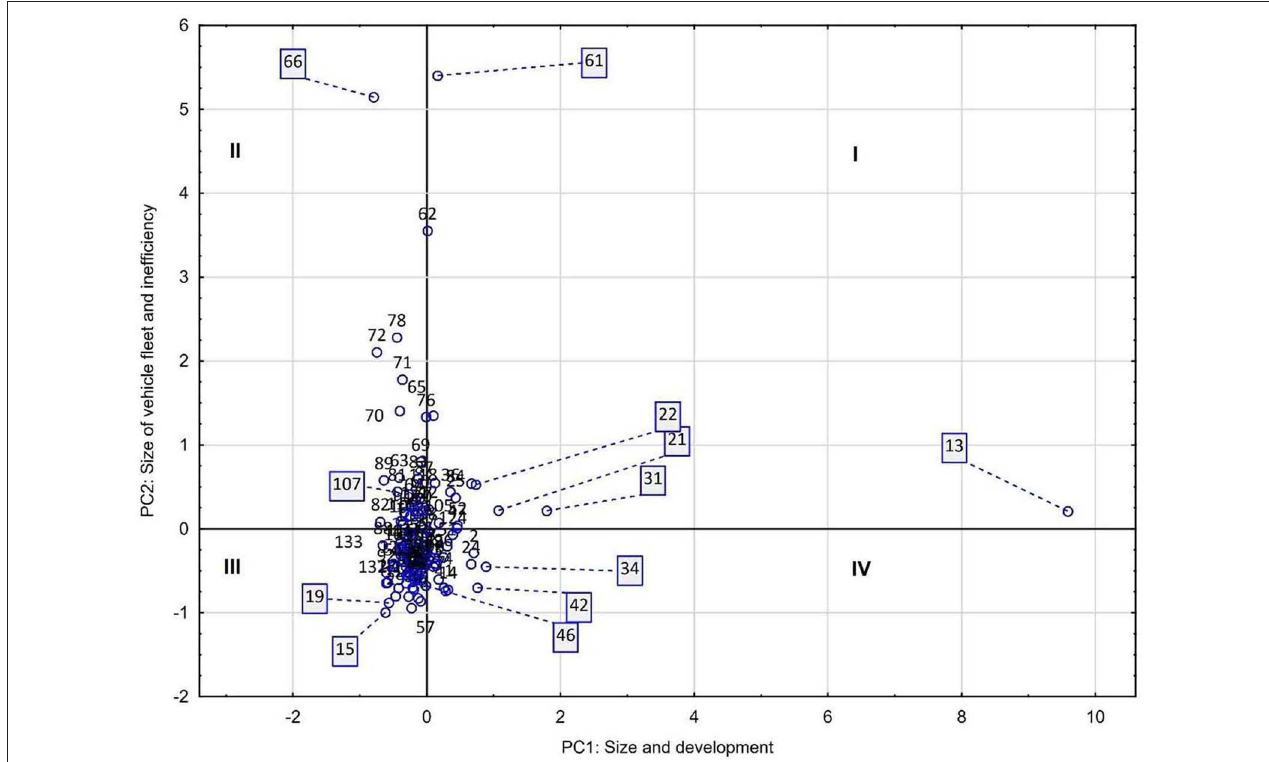
FIGURE 1 | Scatter plot city size and development index (PC1) and size of vehicle fleet and inefficiency index (PC2). A list of names and ID numbers of Mexican cities is provided in Table A2 .